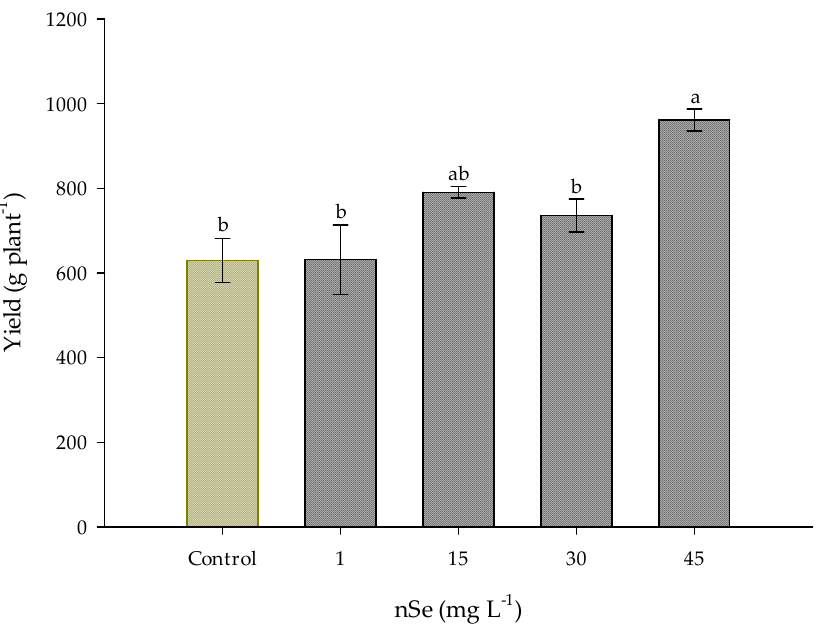
Figure 2. The yield of Jalapeño pepper crop with the application of nSe. Different letters indicate significant differences between treatments (Tukey test p ≤ 0.05). n = 5 ± standard error.